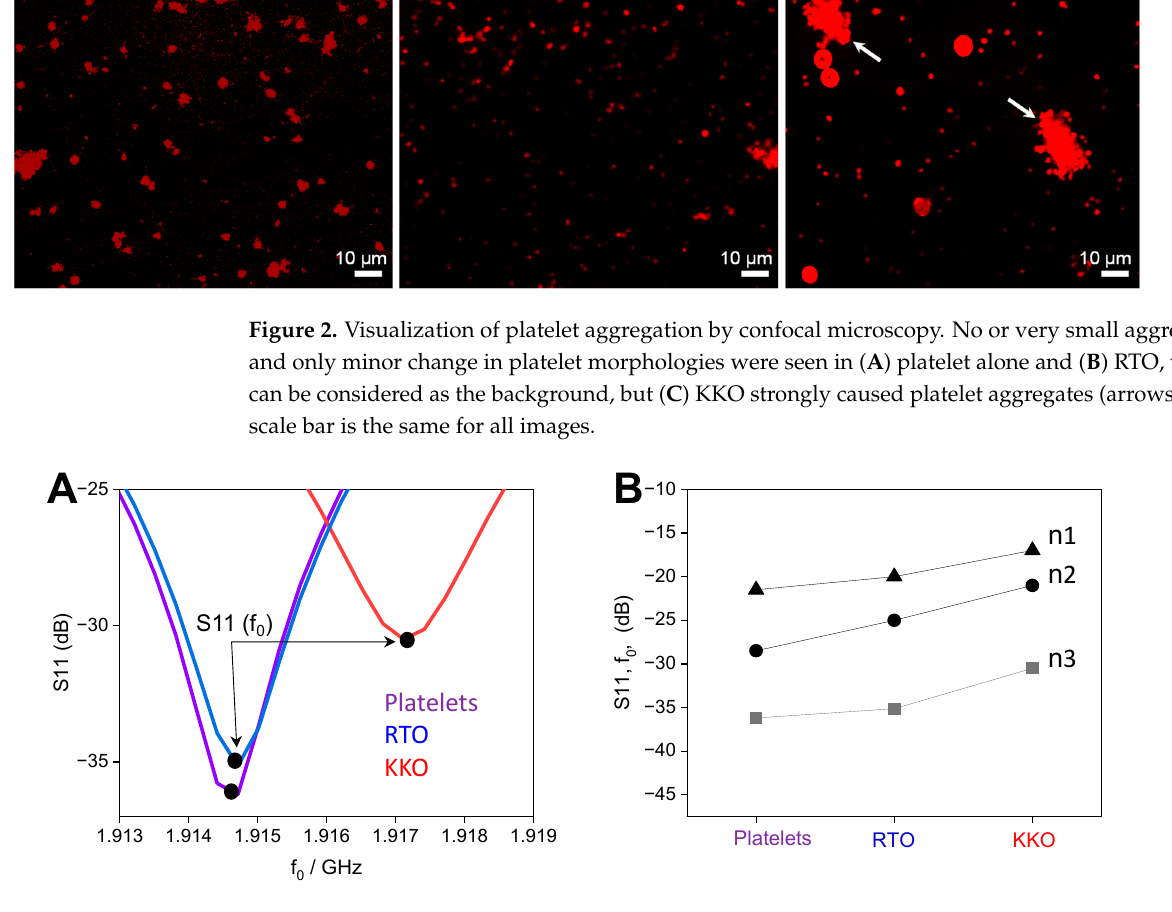
Figure 3. Detection of platelet aggregates with contactless microwave sensor. ( A ) Enlargements show typical − distinguished S11 vs. frequency curves for platelets (purple), RTO (blue), and KKO (red) that allow determining maximal S11 around resonant frequency f 0 , S11(f 0 ), arrows. ( B ) Collection of values from different platelet donors (n = 3) shows the same trend, that is, the lowest negative S11 for KKO, followed by RTO, and highest for the platelet